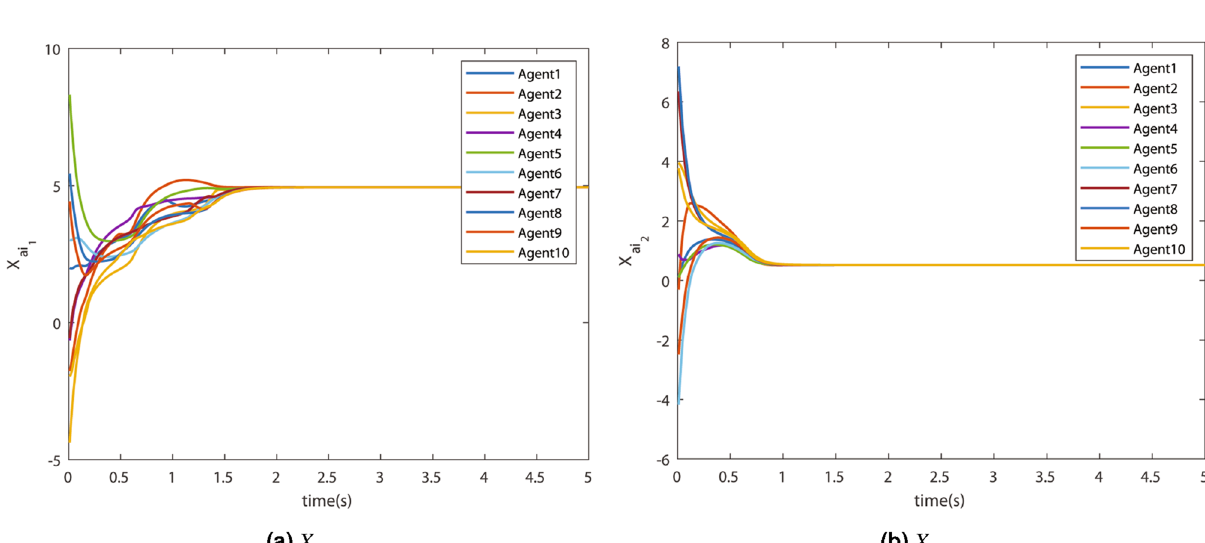
Figure 8. Virtual state